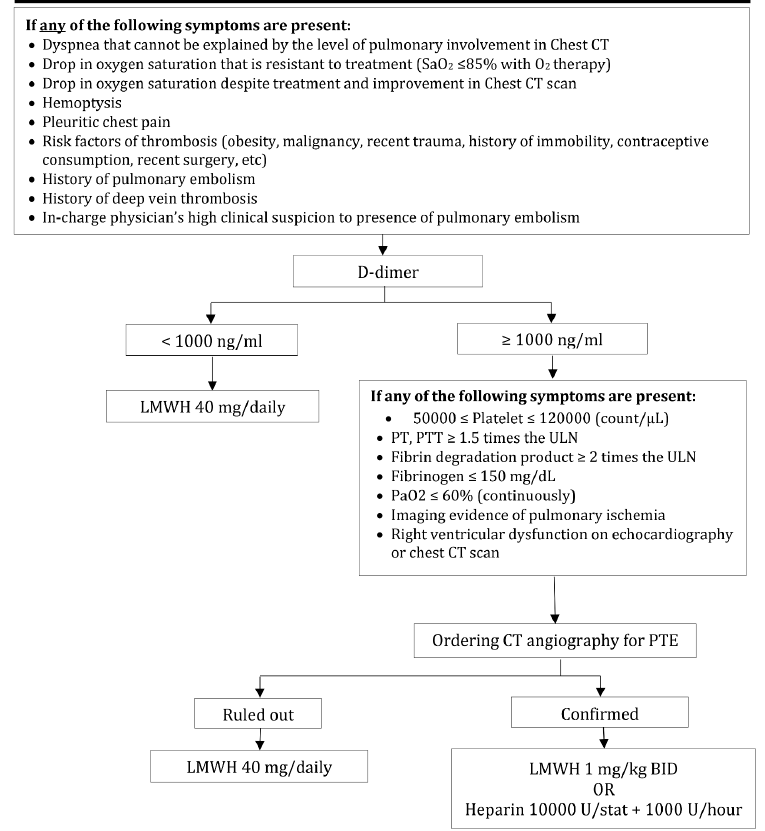
Figure 1. Recommended flowchart for the prevention and treatment of COVID-19 suspected thromboembolism patients. CT: Chest computed tomography scan without contrast; LMWH: Low molecular weight heparin; PTE: pulmonary thromboembolism; ULN: Upper limit of